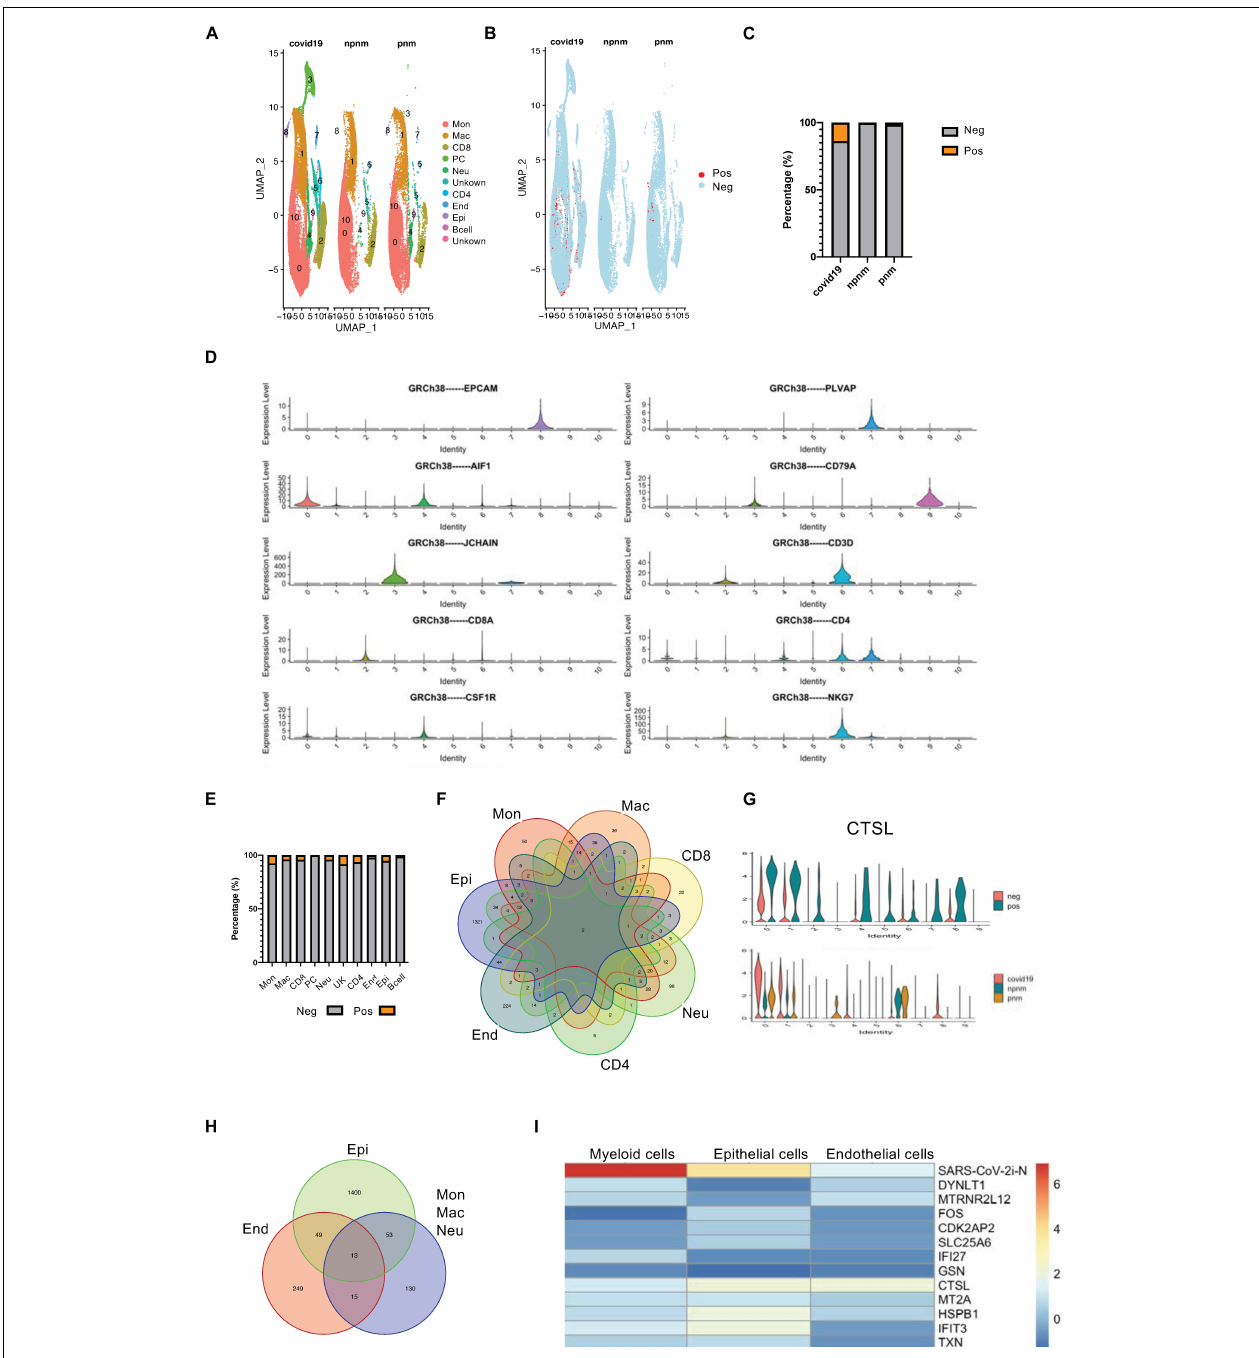
FIGURE 1 | Transcriptome profiling of SARS-CoV-2–infected cells. (A) A UMAP diagram showing the cell clusters in COVID-19-related pneumonia (covid19), control (npnm), and bacterial pneumonia (pnm) samples. (B) A UMAP diagram showing the SARS-CoV-2 positive and negative cells in the COVID-19 pneumonia (covid19), control (npnm), and bacterial pneumonia (pnm) samples. (C) Bar charts to quantify and compare the proportion of SARS-CoV-2 positive and negative cells in the COVID-19 pneumonia (covid19), control (npnm), and bacterial pneumonia (pnm) samples. (D) Violin plots indicating the expression and distribution of marker genes in monocytes (c0), macrophages (c1), CD8 + T cells (c2), plasma cells (c3), neutrophils (c4), CD4 + T cells (c6), endothelial cells (c7), epithelial cells (c8), and B cells (c9). (E) Bar charts to quantify and compare the proportion of SARS-CoV-2 positive and negative cells in the main cell types. (F) A Venn diagram highlighting the intersecting gene signatures of SARS-CoV-2–infected ells. (G) Violin plots indicating the levels of CTSL expression in the SARS-CoV-2-infected and non-infected main cell types. Violin plots indicating the levels of CTSL expression in the SARS-CoV-2-infected and non-infected cell populations in COVID-19 pneumonia (covid19), control (npnm) and bacterial pneumonia (pnm) samples. (H) A Venn diagram highlighting the intersecting gene signatures of SARS-CoV-2–infected myeloid, endothelial, and epithelial cells. (I) A heat map revealing the fold changes of the shared DEGs in the COVID-19-related myeloid, epithelial, and endothelial